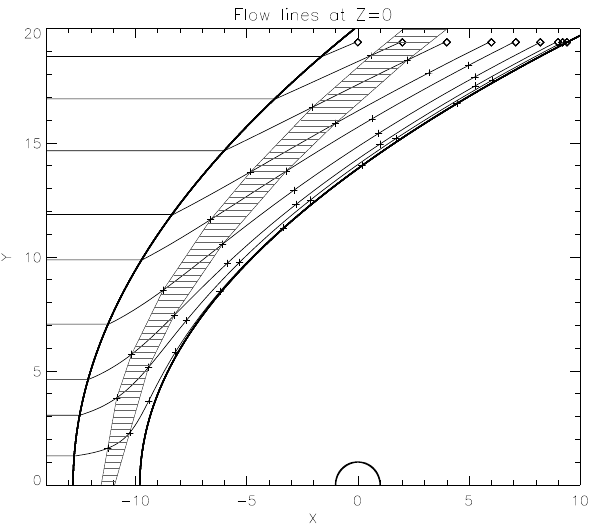
Fig. 1. Flow lines in the XY plane with parabolic models for the shock ( R bs = 12.8 R E ) and the magnetopause ( R mp = 9.8 R E ). These lines corresponds to the magnetic field lines of the KF model for an IMF aligned with the Sun-Earth line. Crosses are superposed on each line and correspond to elapsed times (flow times) of 100s, 200s, 300s, ... from the shock crossing. The striped region corresponds to flow times in the 100s-200s range ( v SW = 400 km/s).